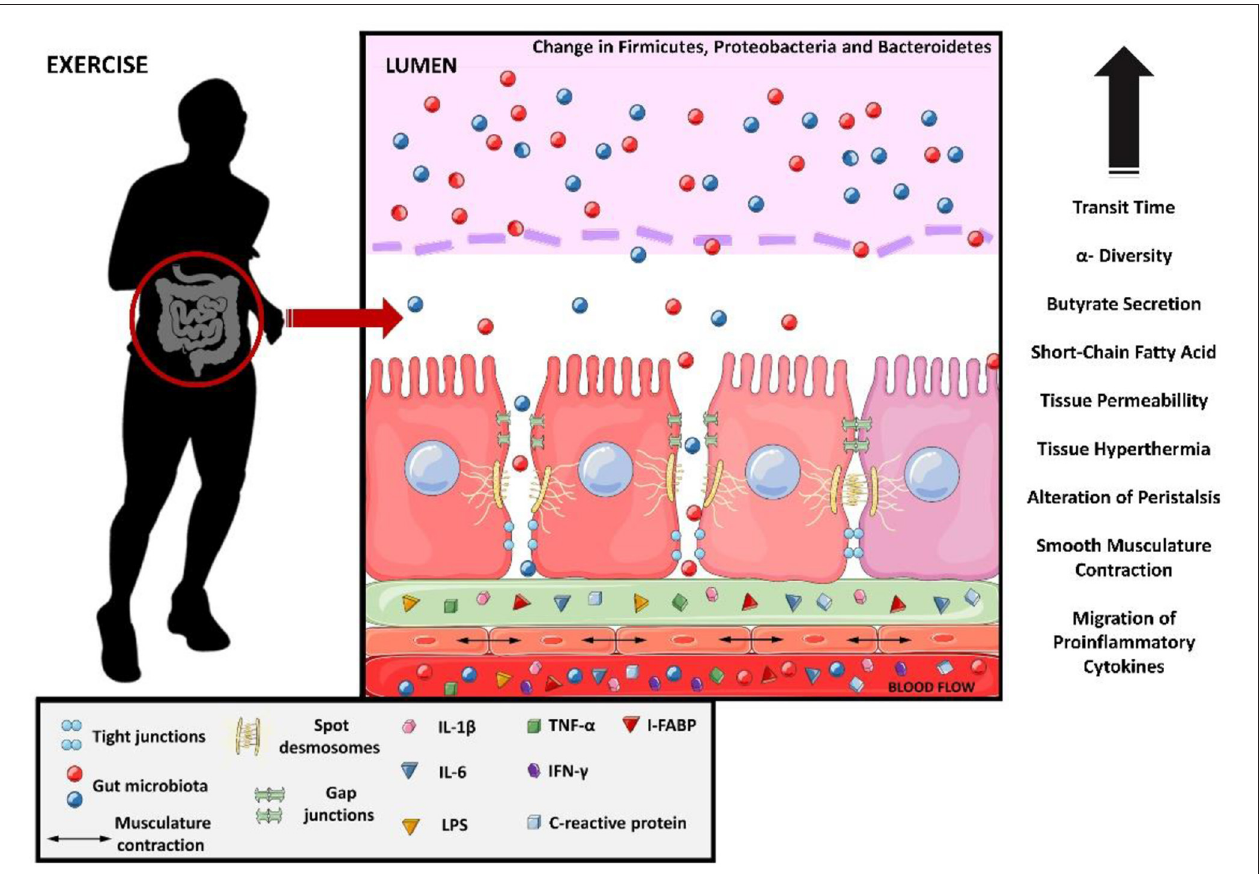
FIGURE 2 | Molecular changes from exercise causing leaky gut. Interleukin 1 beta, IL-1B; interleukin 6, IL-6; lipopolysaccharides, LPS; tumor necrosis factor-alpha, TNF-alfa; interferon gamma, IFN-y and intestinal fatty-acid binding protein,